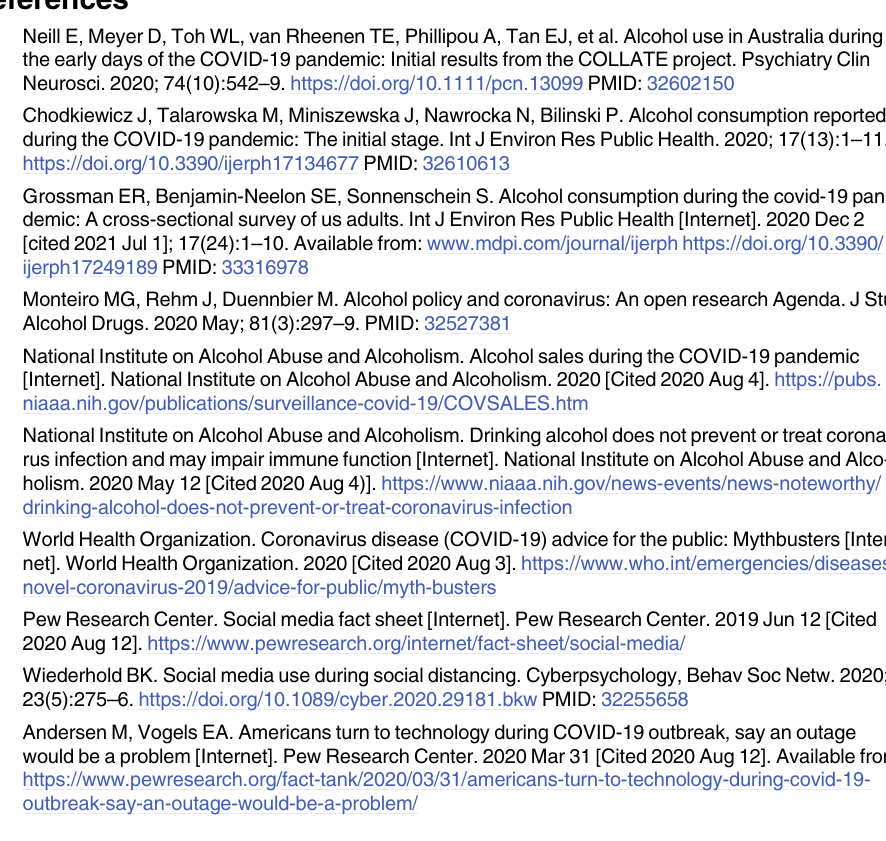
S1 Table. Sample socio-demographics by Twitter, Instagram, Facebook, and multiple social media platform use ( N =